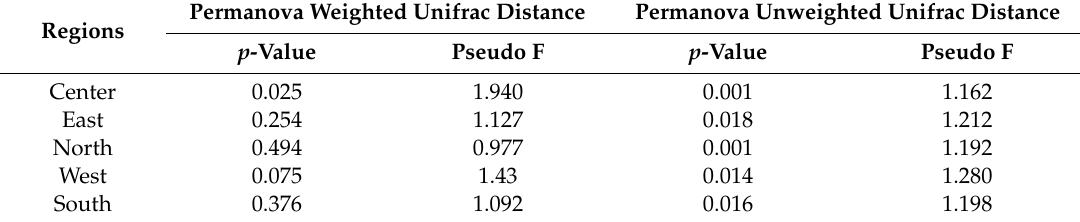
Table 2. Abundance (permanova weighted unifrac distance) and composition (permanova unweighted unifrac distance) analysis of the microbiota associated with A. sexdens collected at di ff erent geographical locations. This table shows significant di ff erences mainly in the composition between the habitat (natural: Cerrado and Atlantic Forest; and agricultural: sugarcane, citrus and eucalyptus) in each geographical